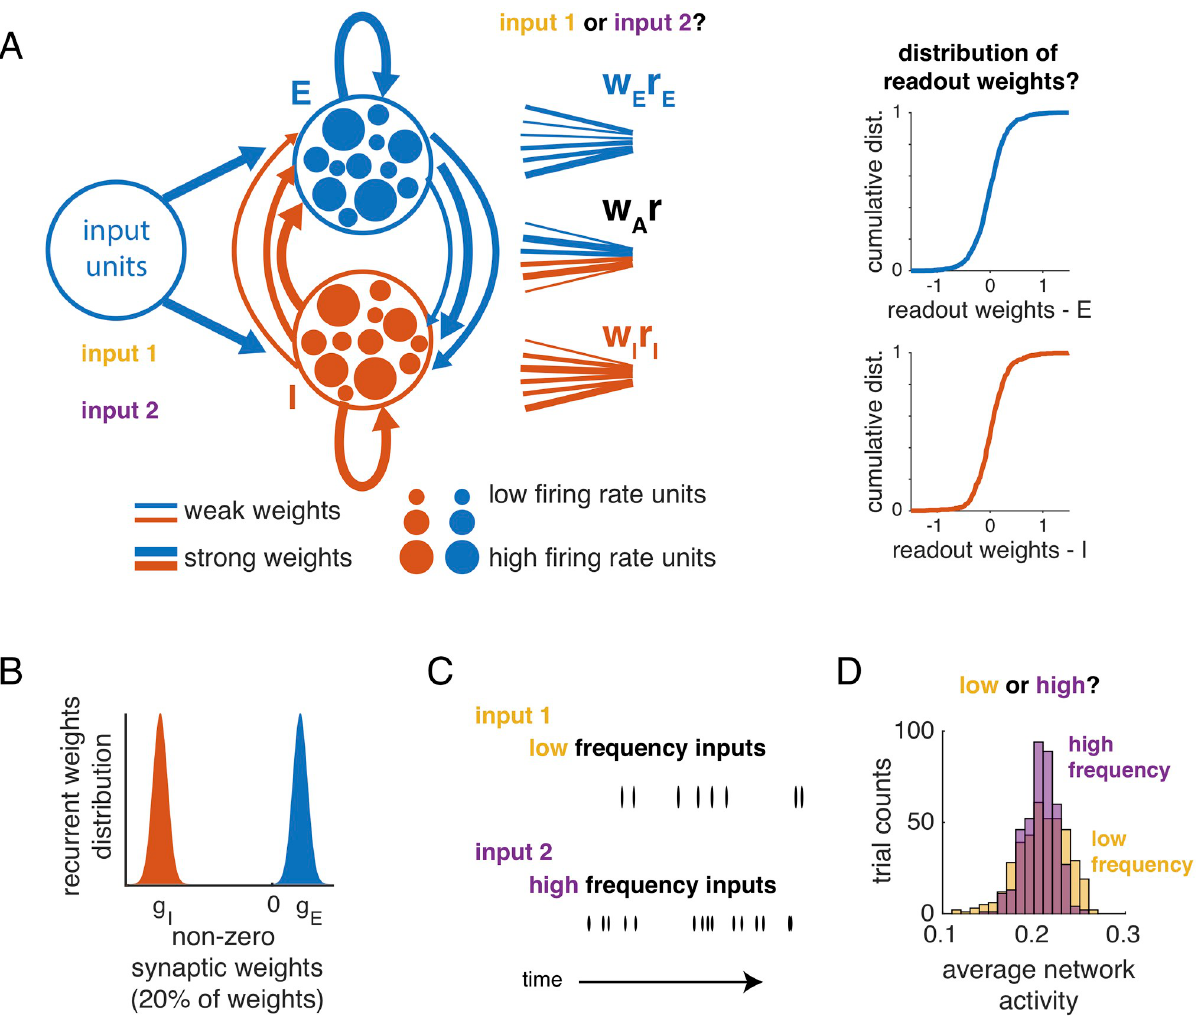
Fig 1. Overview: Simulation of an input frequency discrimination task in a recurrent network of excitatory and inhibitory neurons with random connectivity. A: Recurrent E-I network of randomly connected neurons. Synaptic weights are heterogeneous (line thickness), and connectivity in the network is random. Inputs to the network have the same pattern of spatial activation but different temporal features. Readouts of network activity (from all neurons, or restricted to excitatory or inhibitory neurons) discriminate between stimulus categories. We then analyze the distributions of readout weights. B: Distributions of non-zero inhibitory (shaded red) and excitatory (shaded blue) synaptic weights. 20% of the weights are non-zero. C: Inputs to the network are pulses arriving at random times with low (top row, yellow) or high (bottom row, red) average frequency. D: Histogram of population average network activity over trials for low- and high-frequency stimuli. Average network activity is not informative of input categories.